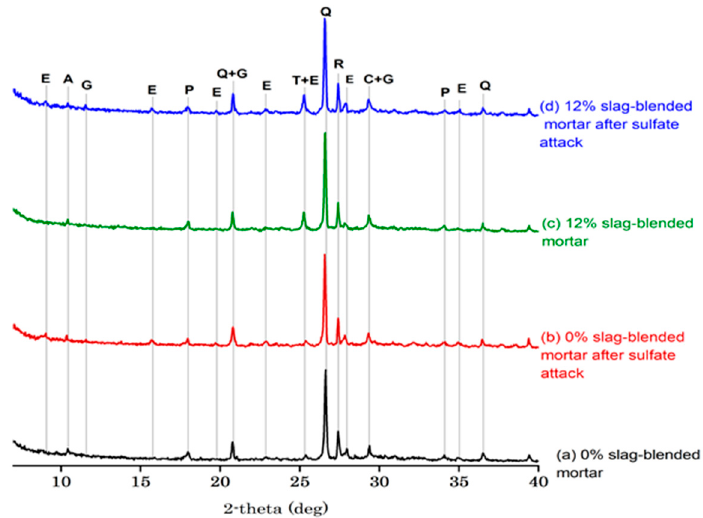
Figure 13. XRD pattern of slag-blended mortars (E = ettringite, A = tetra calcium aluminate hydrate, G = gypsum, P = portlandite, Q = quartz, T = TiO 2 (anatase), R = rutile, C = calcite, CSH = calcium- silicate-hydrate).